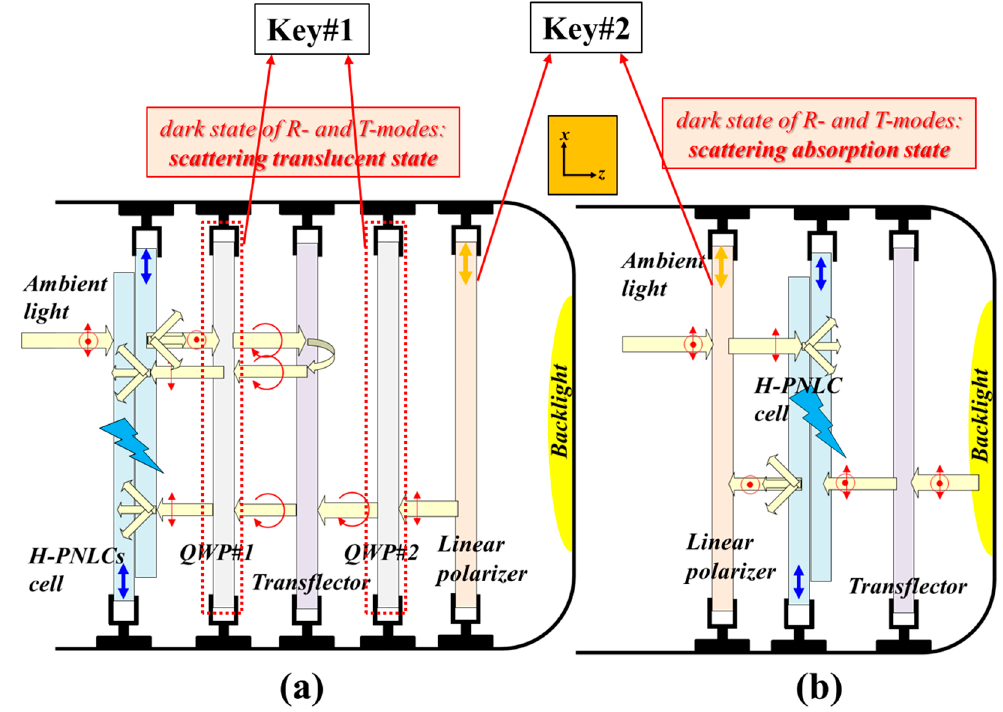
Figure 9. Comparisons between ( a ) the common ST-TRLCD (Figure 1b) and ( b ) the reported ST-TRLCD#2 (Figure 4b) using an H-PNLC cell. Key#1 and Key#2 are the elimination of QWPs and the rearrangement of linear polarizer, respectively.